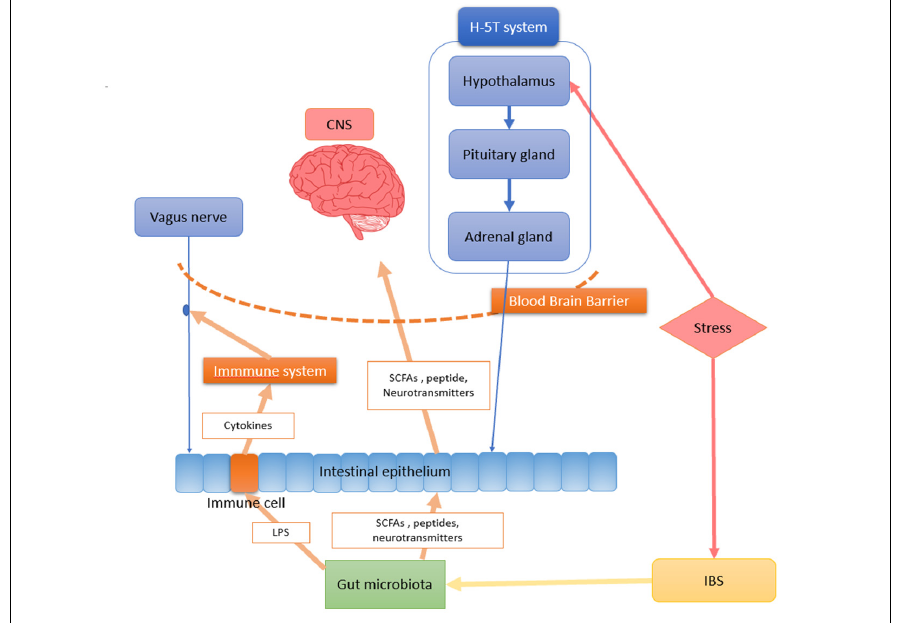
Figure 1. The communication pathway of the gut–brain axis in a depression patient. The HPA axis is activated under internal or external pressure [72]. The hypothalamus activates the release of CRH, promotes the release of ACTH by the pituitary gland, and results in the release of cortisol by the adrenal gland [72]. Cortisol is a hormone that affects intestinal integrity, motility, and mucus production, inducing changes in the composition of intestinal microbiota. In patients with